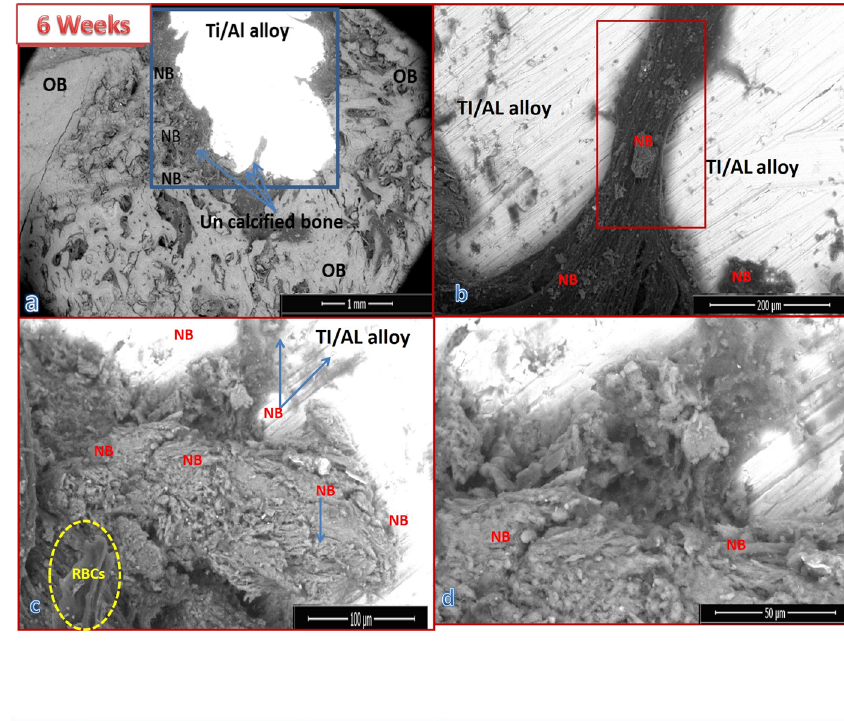
Fig. 6 SEM micrographs with different magni fi cations for a cross-section of bone defect drilled in the dog femur and grafted with uncoated Ti/Al alloy for 12 weeks: a at